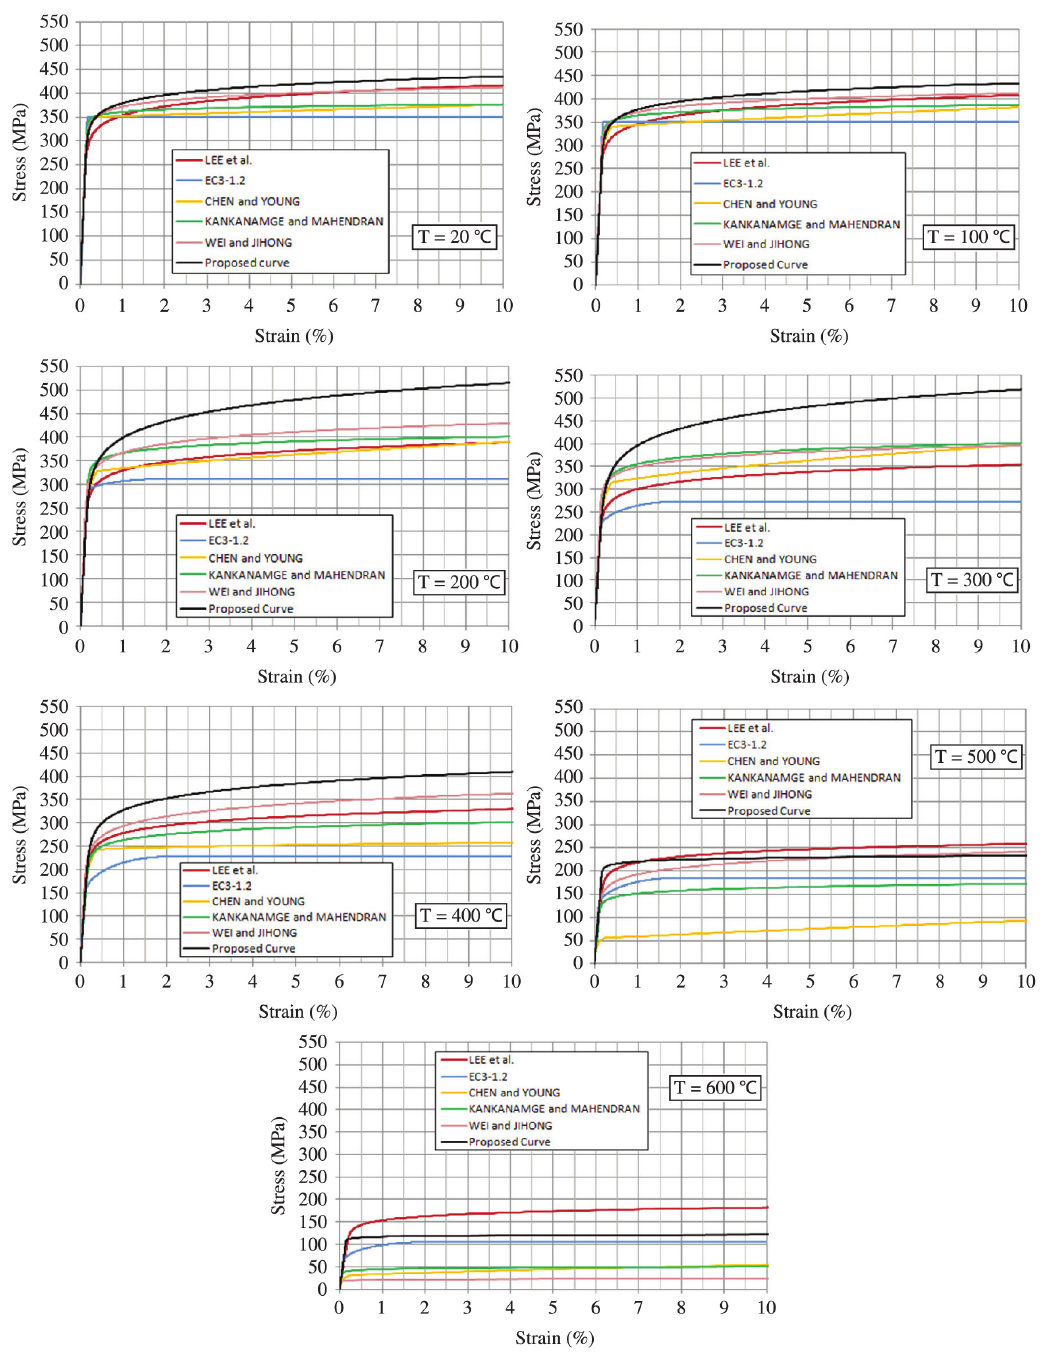
Figure 10. Stress-strain curves for each temperature, according with available and proposed